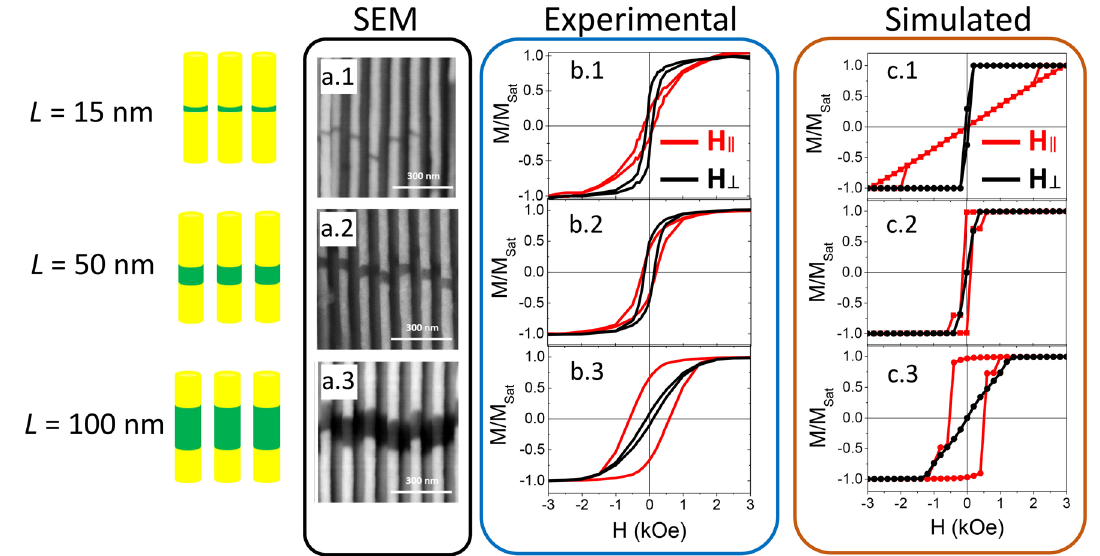
Figure 1. ( a ) SEM cross-sectional images of the nanowires’ length distribution: ( a.1 ) L = 15 ± 1 nm; ( a.2 ) L = 50 ± 3 nm and ( a.3 ) L = 100 ± 4 nm. ( b ) Normalized magnetic hysteresis loops of Au/Ni/Au NWs with lengths ( b.1 ) L = 15 nm, ( b.2 ) L = 50 nm and ( b.3 ) L = 100 nm, with the applied magnetic field parallel (red line) and perpendicular (black line) to the NWs’ long axis. ( c ) Normalized simulated magnetic hysteresis loops of Ni NWs with lengths ( c.1 ) L = 15 nm, ( c.2 ) L = 50 nm and ( c.3 ) L = 100 nm, with the applied magnetic field parallel (red line) and perpendicular (black line) to the NWs’ long